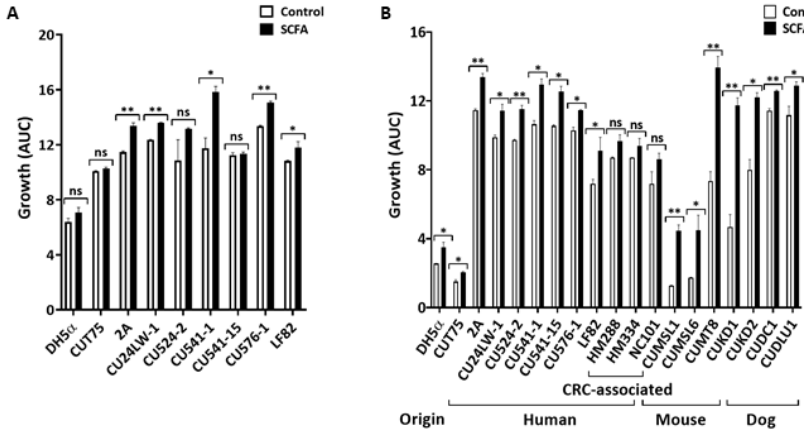
Figure 1. Ileal SCFA promote E. coli growth in vitro. Overnight culture of E. coli was diluted (1:100) into fresh LB ( A ) or M9 ( B ) media containing either 12 mM NaCl (Control) or SCFA at pH = 7.4. To simulate